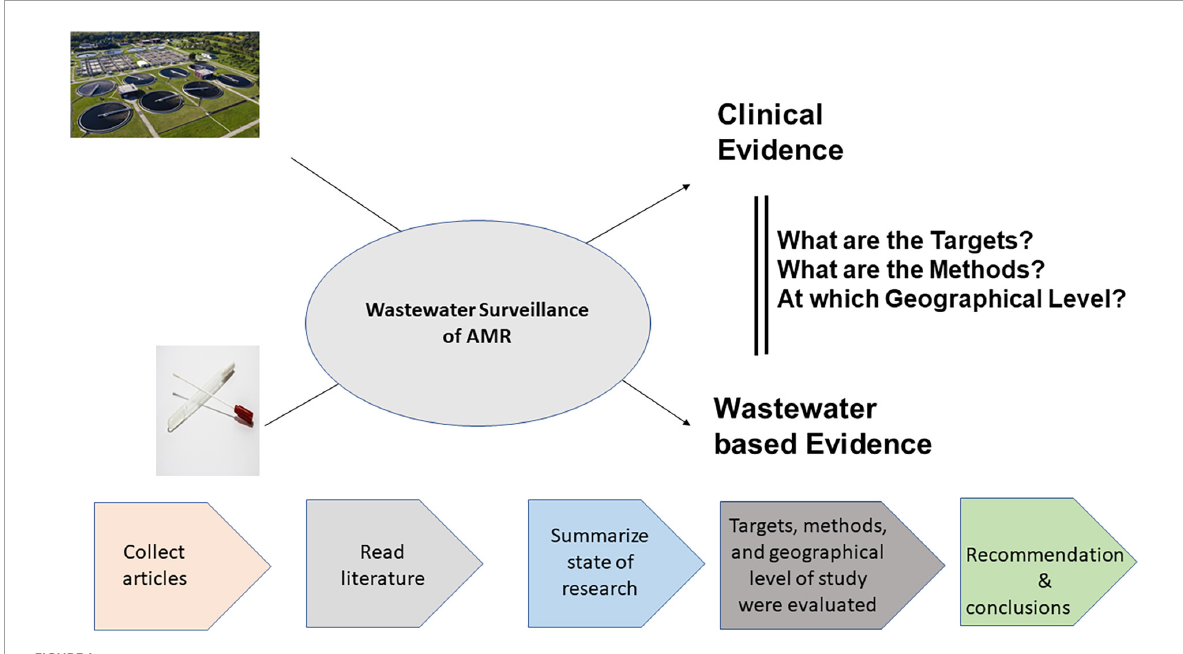
FIGURE1 Graphical representation of study design and summary.